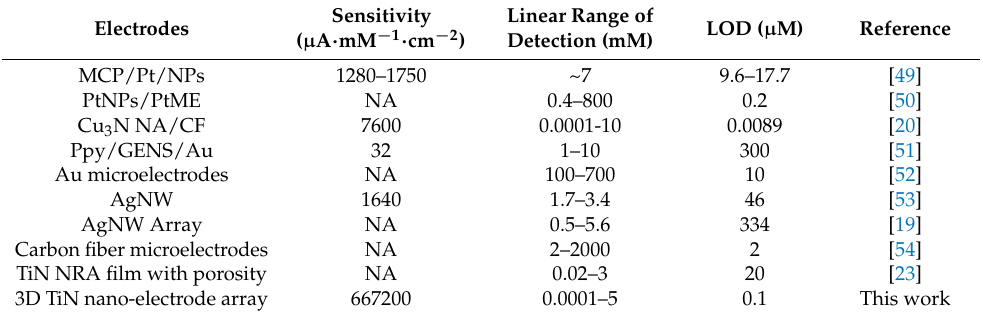
Table 2. The comparison of the reactivity of 3D-NEA and the nanomaterial modified electrodes to H 2 O 2 .